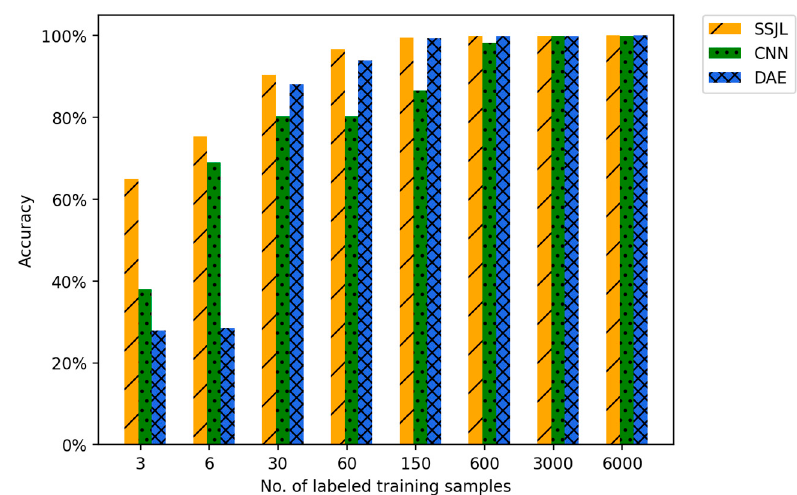
Figure 13. Accuracy comparison of different methods on MFPT dataset.